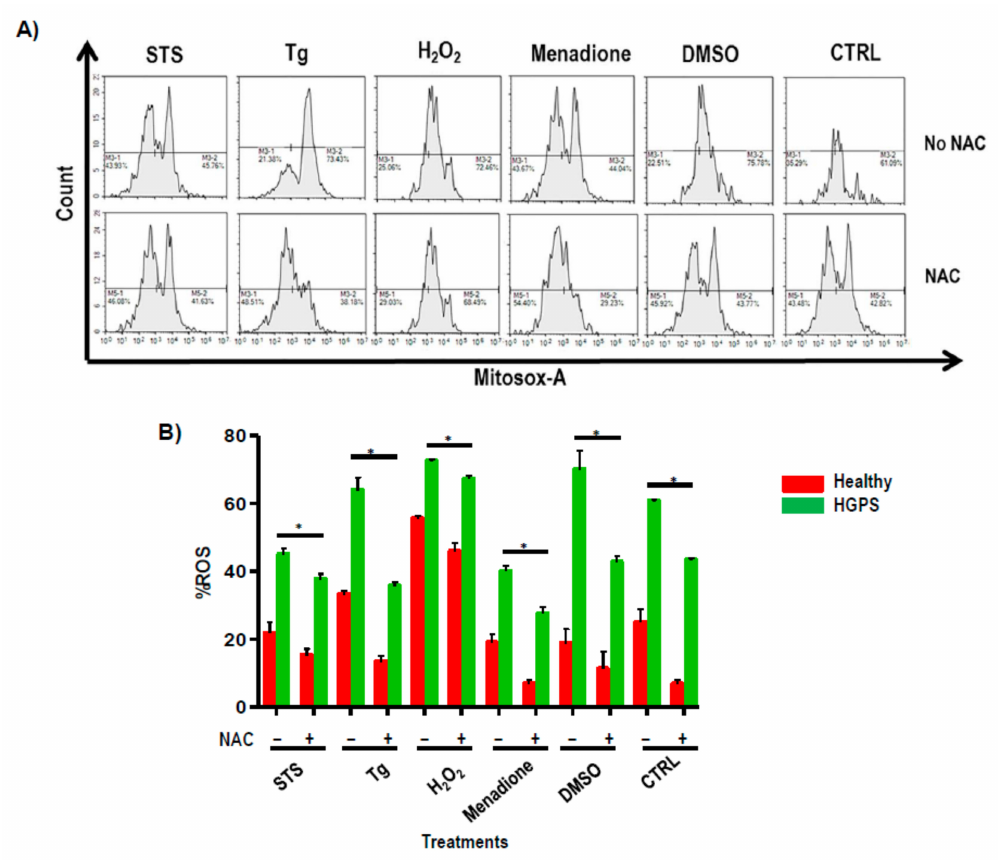
Figure 6. Reactive oxidative species study. ROS percentage assessed by means of flow cytometry from healthy (AG03257, AG03258, AG03512, and AG06299) and HGPS (AG03198, AG03199, AG03513, and AG06917) human skin fibroblasts treated with or without NAC. ( A ) Representative FAC histogram of mitochondrial superoxide activity using NovoExpress software (Agilent, CA, USA) from HGPS skin fibroblasts treated with or without NAC. ( B ) Histograms represent percentages of ROS. Bars are means ± SEM from three independent experiments. * p < 0.05 was considered statistically significant versus healthy cell lines. STS = staurosporine; Tg = thapsigargin; H 2 O 2 = hydrogen peroxide; DMSO = dimethyl